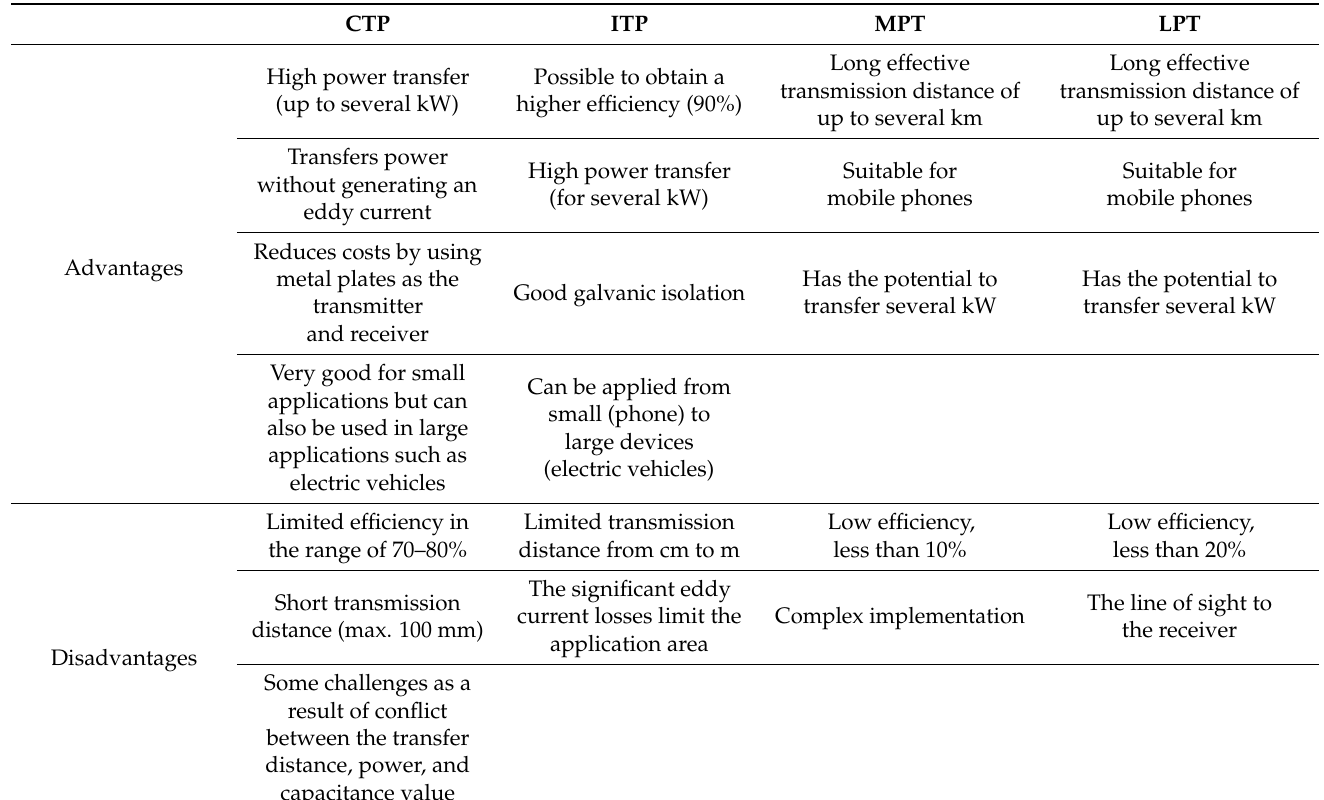
Table 2. Advantages and disadvantages of the WPT technology [29].